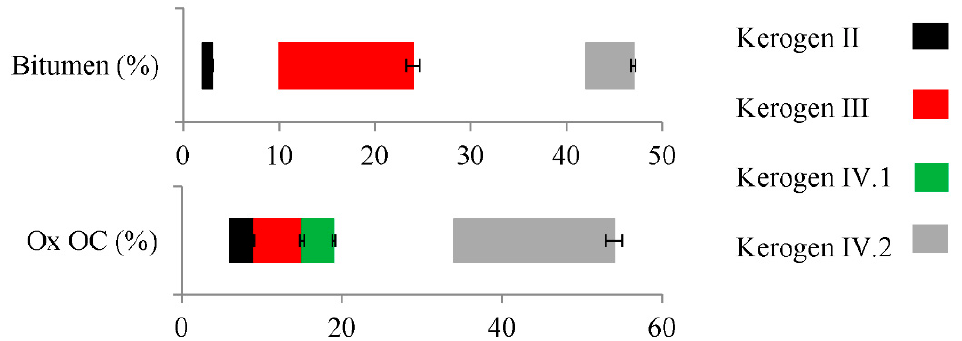
Figure 2. The content of bitumen and the content of oxidized organic compounds (Ox OC) in kerogen II, III, IV.1, and IV.2 samples. All the differences are statistically significant (significance level: p < 0.05). The error bars represent standard deviation.